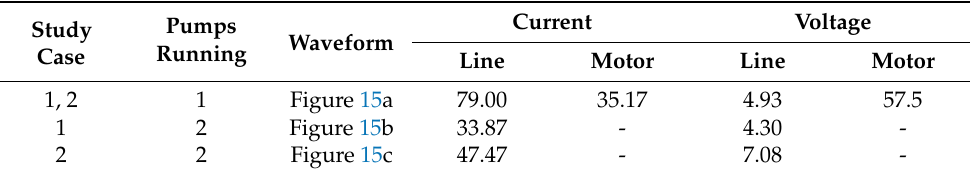
Table 1. Total Harmonic Distortion (THD)